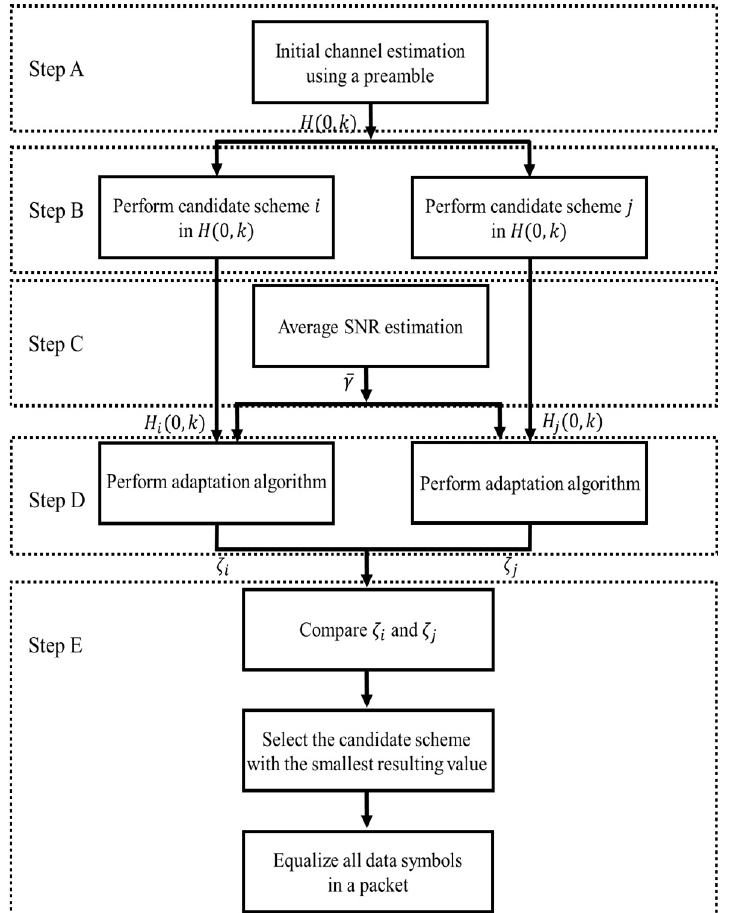
Figure 4. Flowchart of the proposed